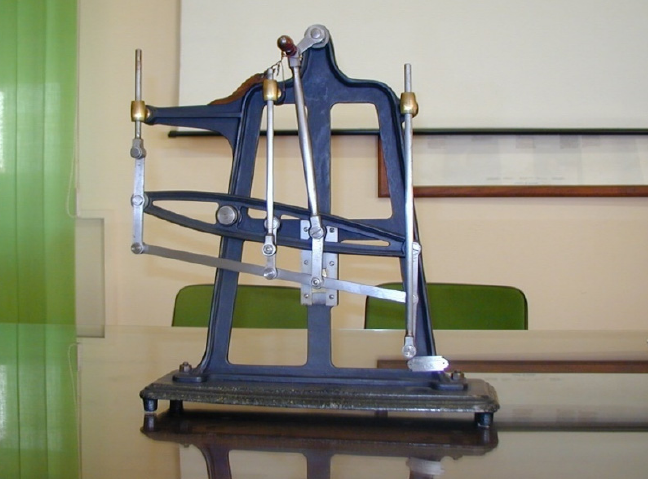
Figure 17. The iron-made model the Watt linkage for approximate-line guide.